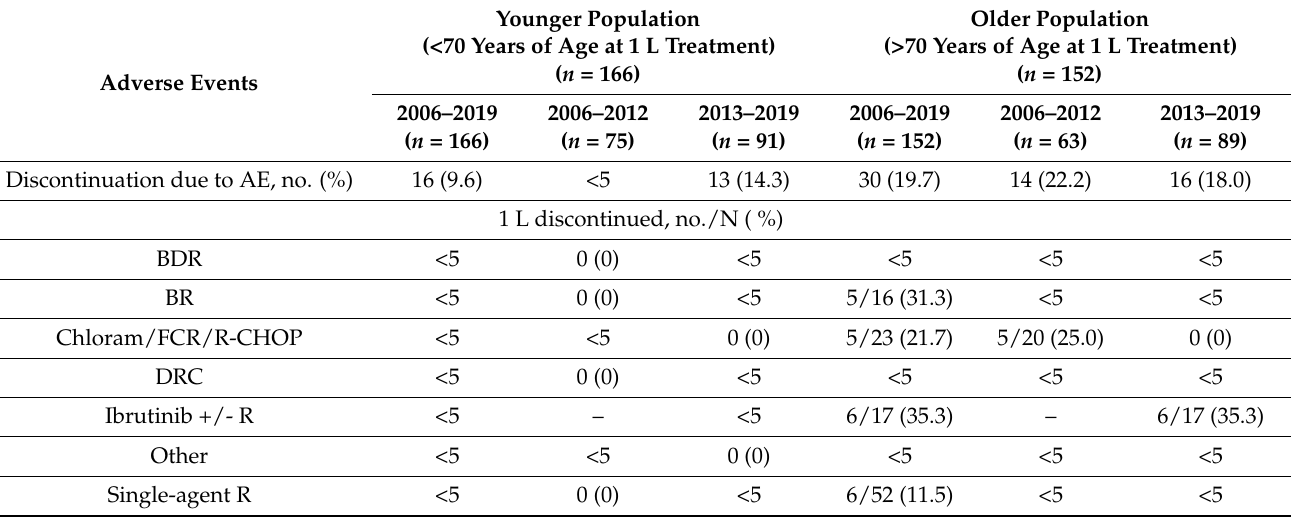
Table 6. Adverse events that resulted in primary treatment discontinuation in veterans with Waldenström macroglobuline- mia, 2006 to 2019.